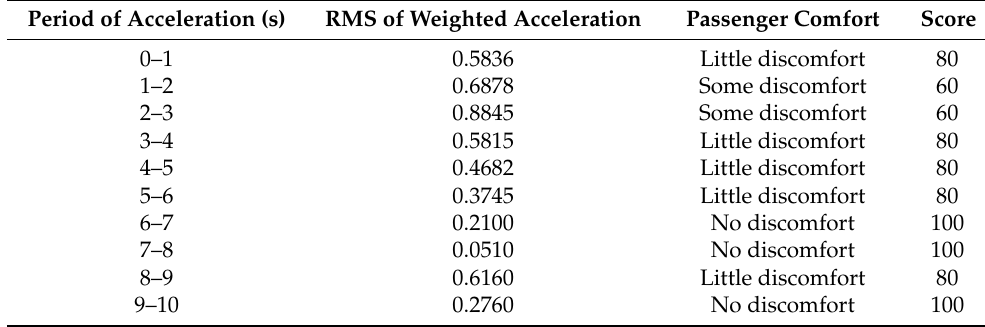
Table 5. Calculation results of RMS of weighted acceleration when straight vehicle goes ahead. Period of Acceleration